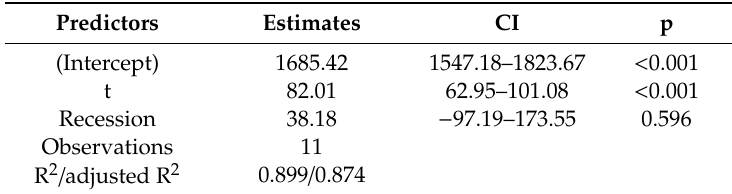
Table 4. Model 2 results for business enterprise sector.